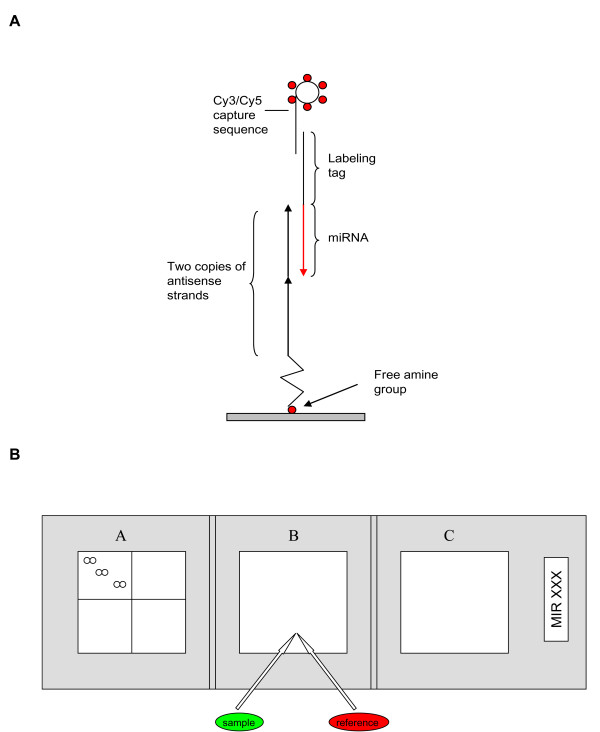
miRNA microarray fabrication and hybridization strategy. (A) The probes were two copies of antisense oligos of mature miRNA. The 5' ends of the probes were amino modified. The probes were linked to epoxy-coated slides covalently. miRNA samples were tagged and hybridized to the slides. (B) Each slide contained three identical blocks and each block was hybridized with two-colored paired samples. There were 6 duplicated probes for each miRNA as shown in block A. MIR xxxx, series number.